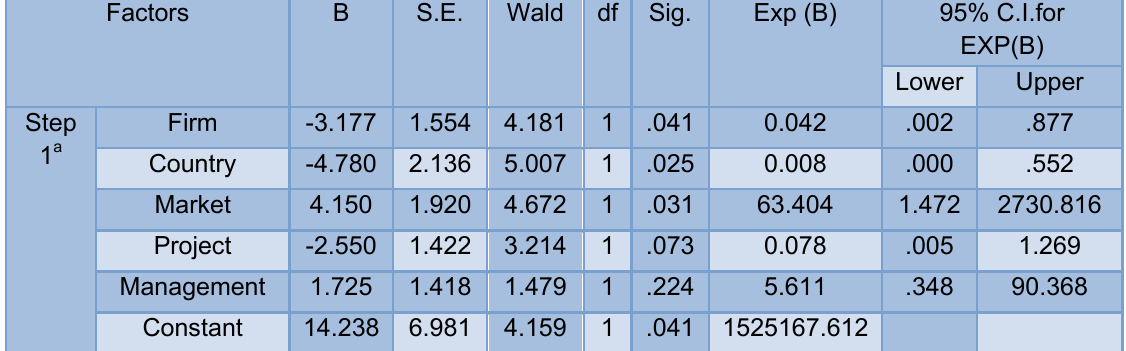
Table 10: Variables in the Equation for EL